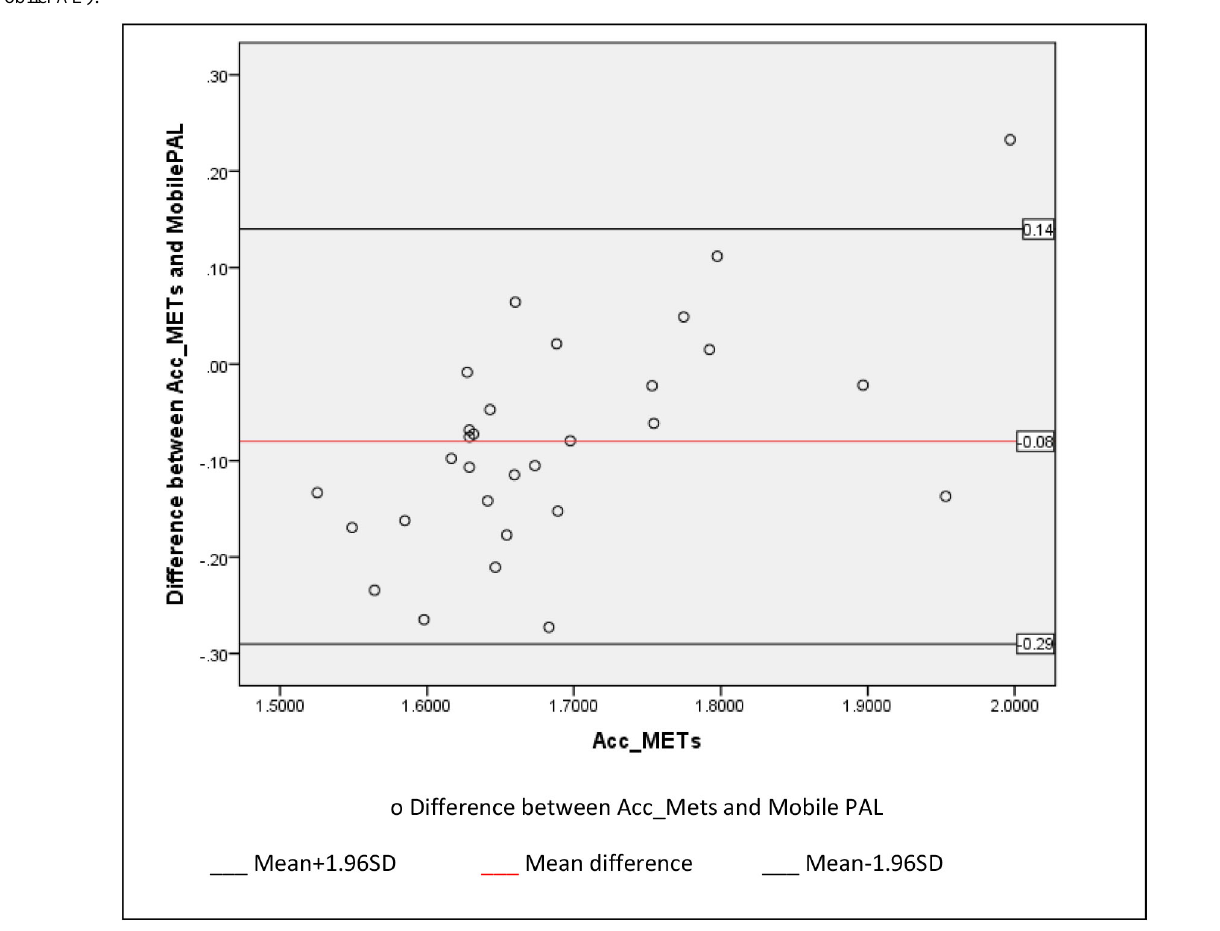
Figure 2. Bland-Altman plot comparison of energy expenditure obtained using accelerometry (Acc_METs) and the mobile phone questionnaire